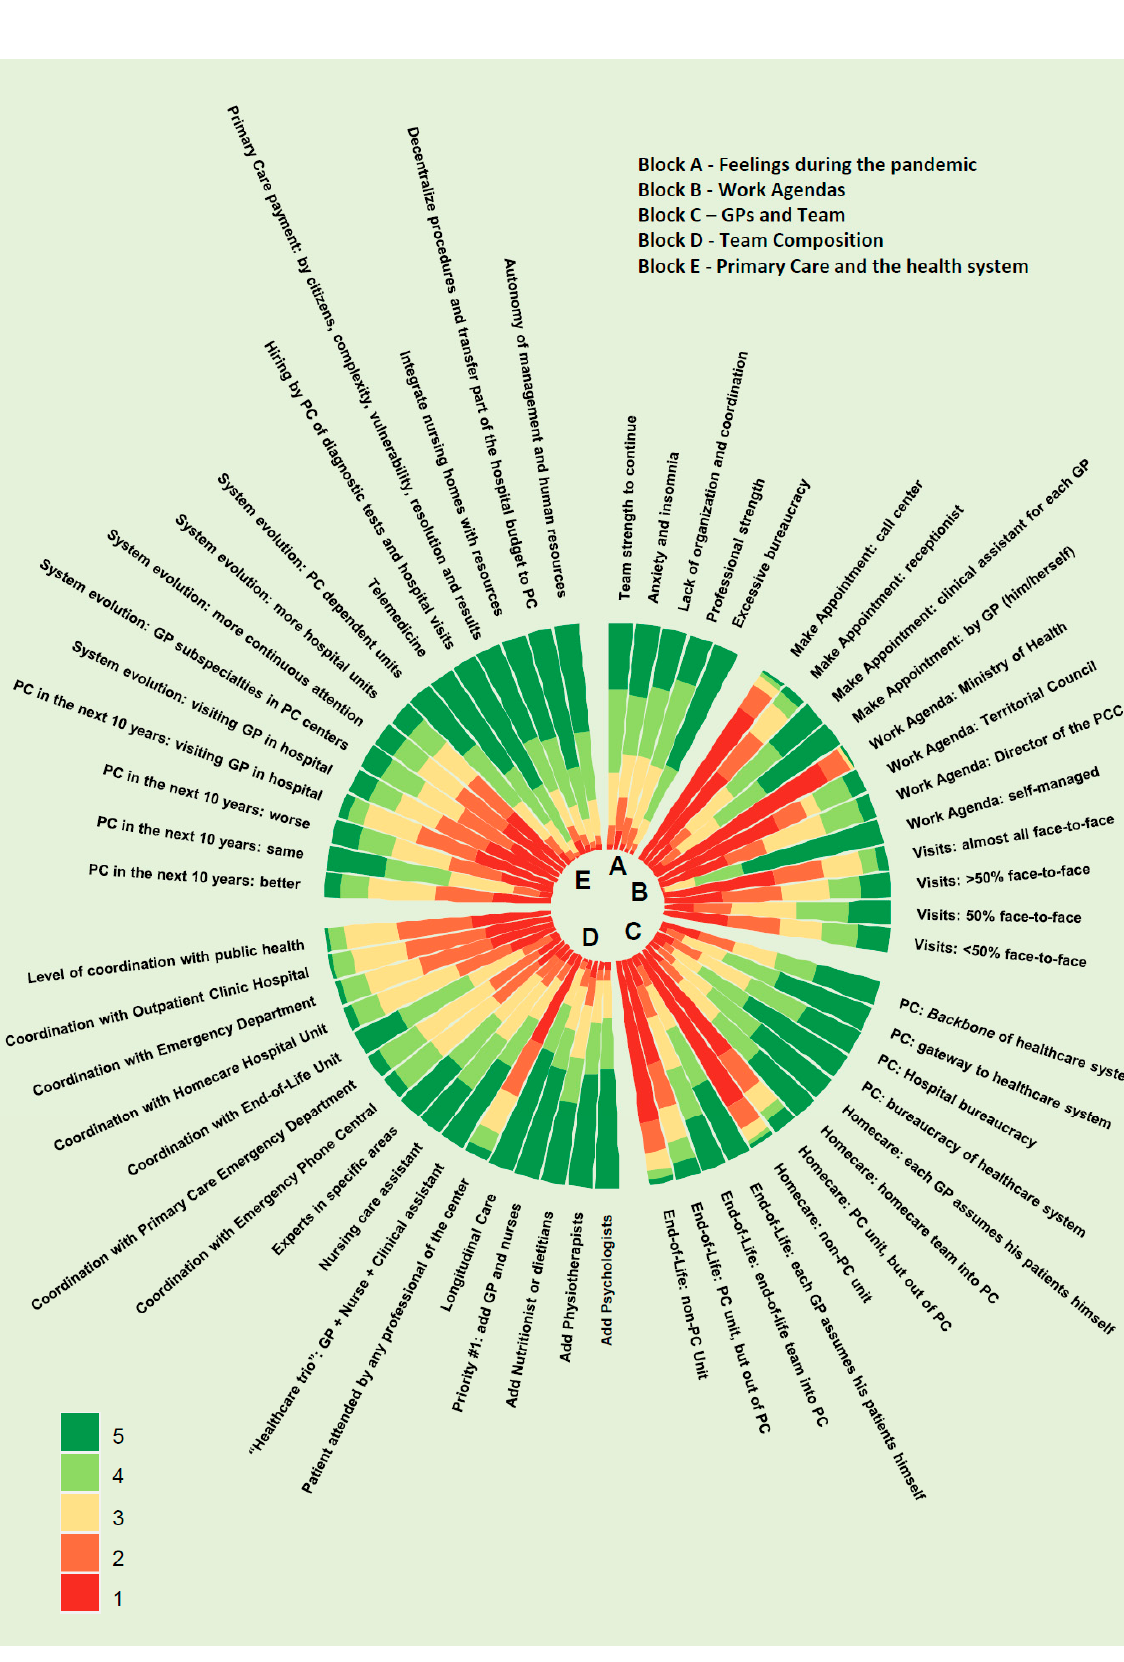
Figure 1. Second section of the questionnaire with 22 questions distributed in 5 blocks.